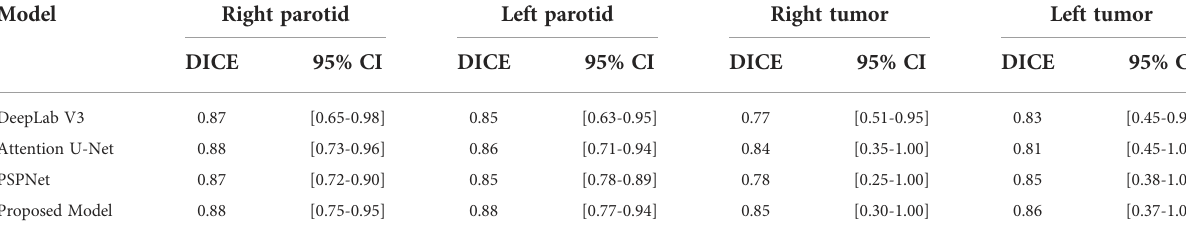
TABLE 3 The comparison with other models.